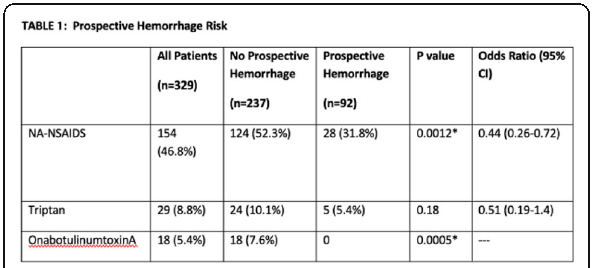
Table 1 (abstract P0121). See text for